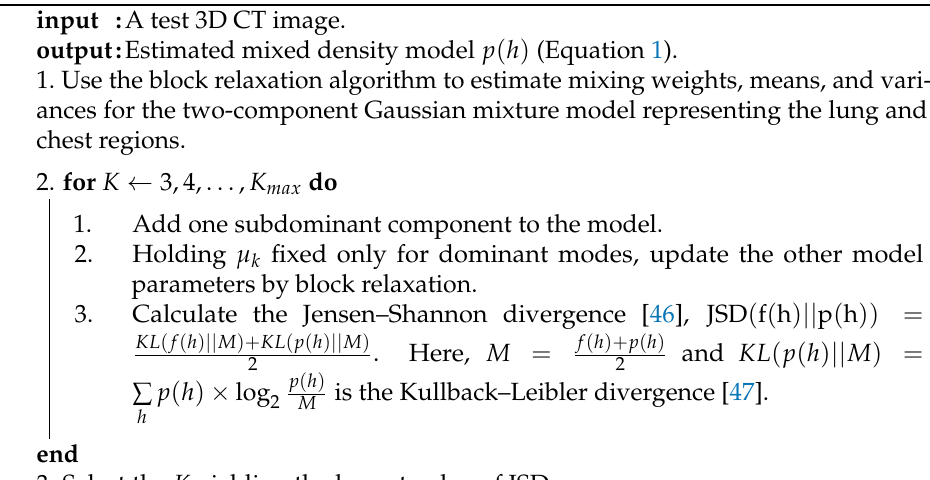
Algorithm 1: Estimation of the proposed probabilistic model parameters